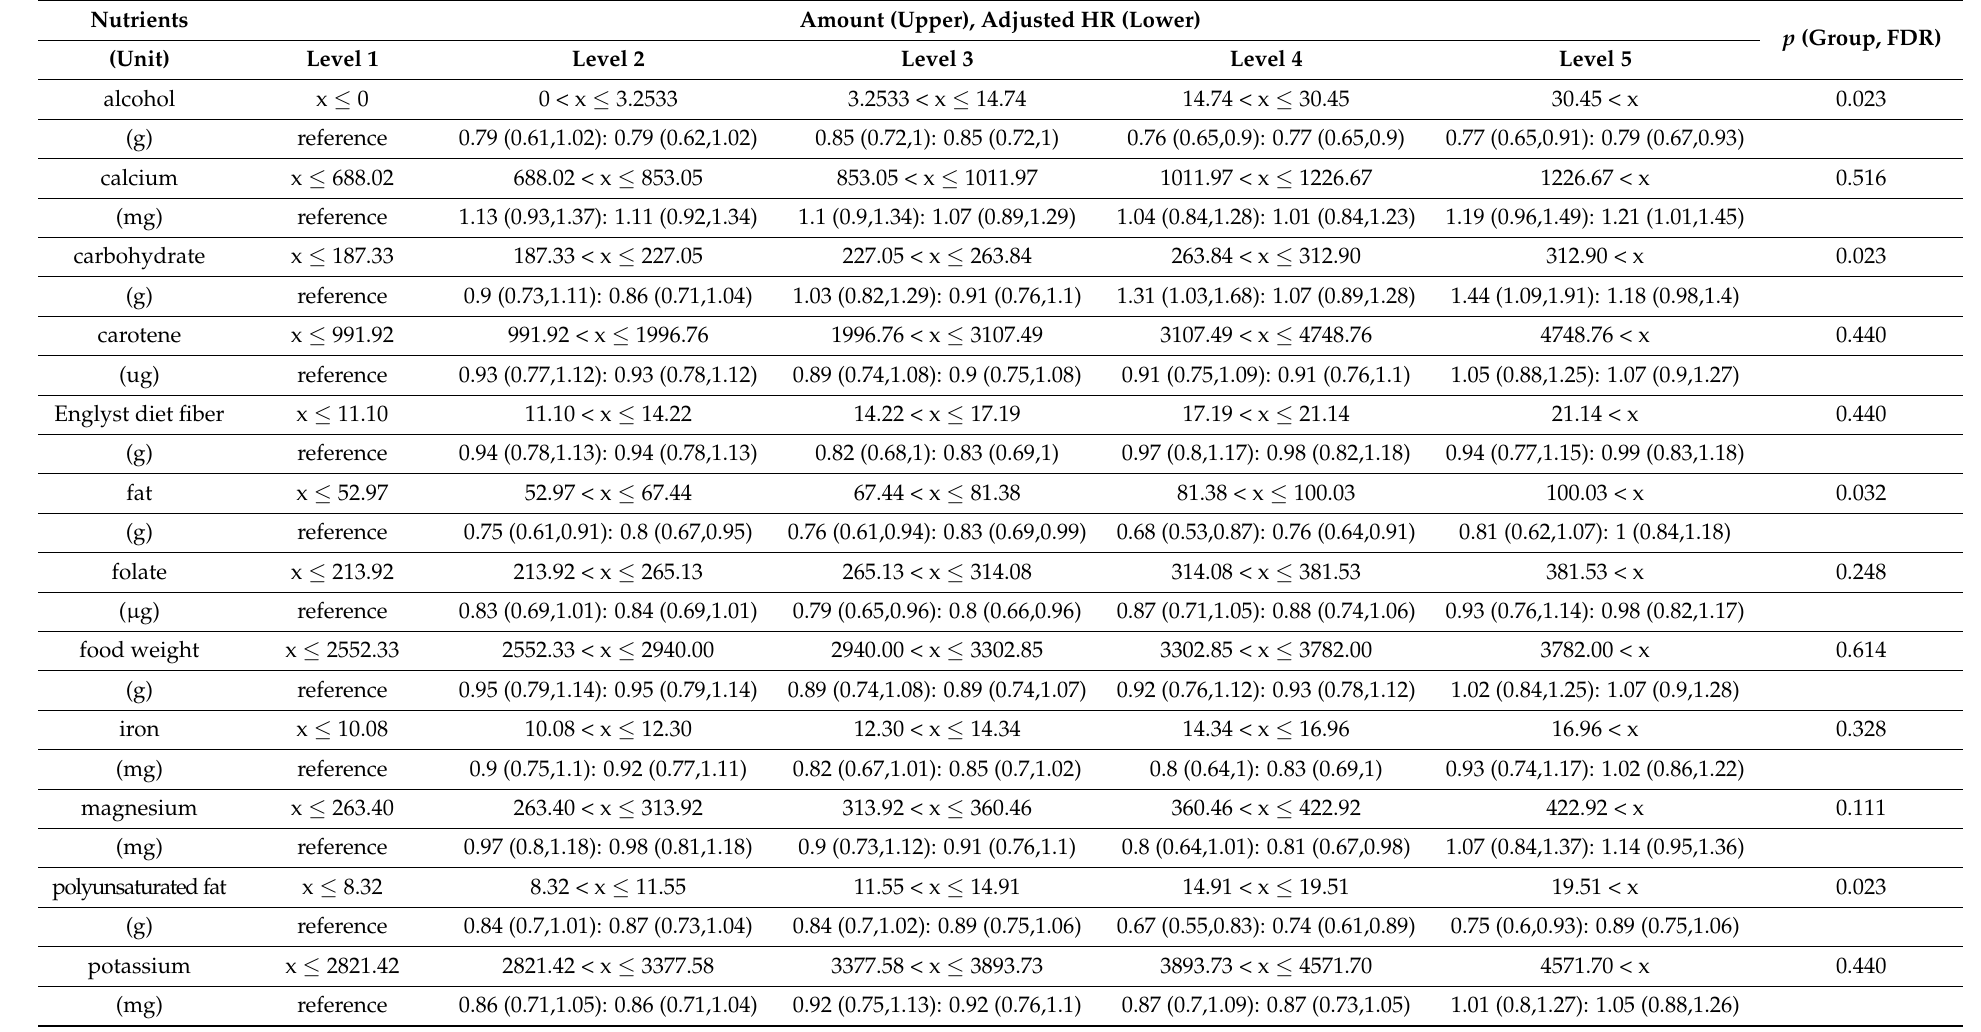
Table 3. Nutrient intake level (amount and adjusted HR as well as 95% CI) of each group and corrected p values of overall group differences after adjusting for the quintiles of energy intake level (left) and P values in the main analyses